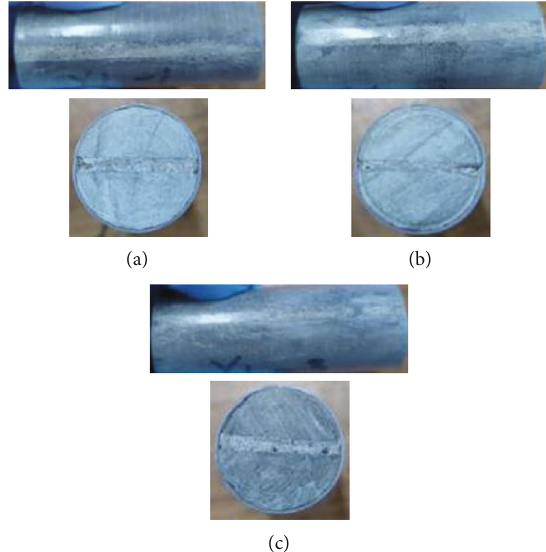
Figure 2: Arti fi cially fractured natural core.